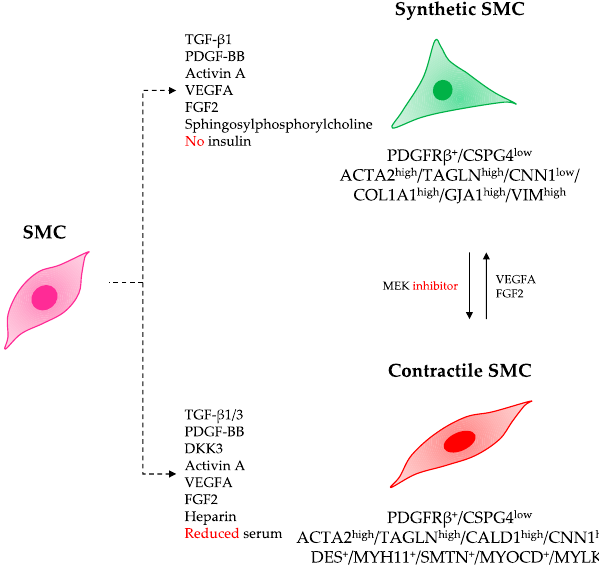
Figure 4. Proposed strategies to derive synthetic and contractile SMCs from hiPSCs. Differentiation of hiPSCs into specialized SMC phenotypes can be modulated by combinations of growth factors and cytokines, and by concentration of serum. Phenotypic markers that define each phenotype are listed. Taura et al. [69] were the first to generate mural cells from the four hiPSC cell